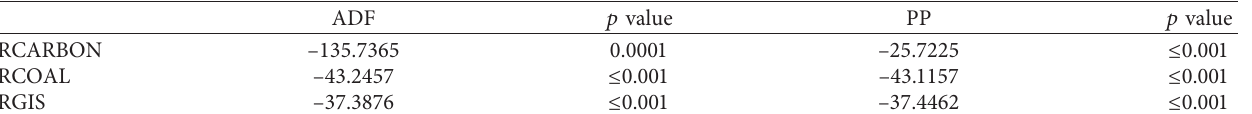
Table 5: Stationarity